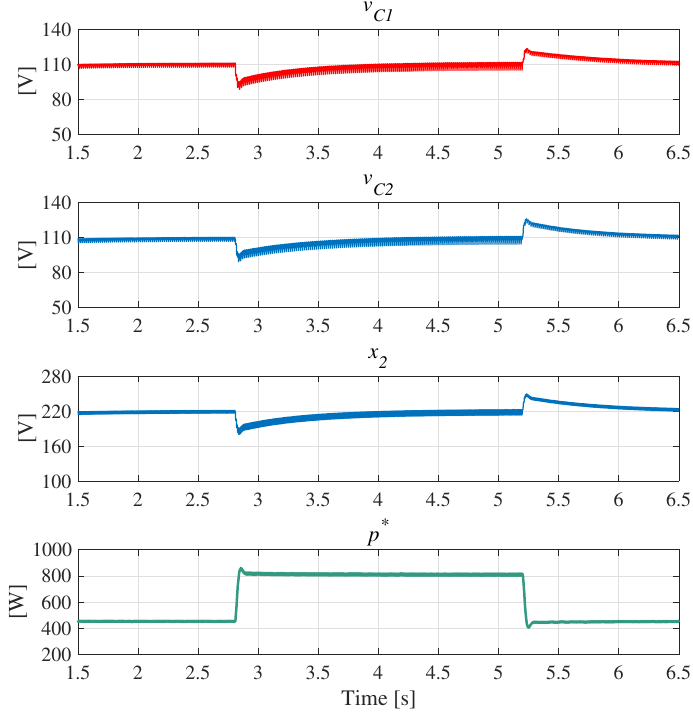
Figure 7. Transient responses of the voltage across each capacitor of the DC-Link v C 1 , v C 2 , the sum of the capacitors voltage x 2 , and the power reference calculated in the regulation loop p ∗ during a load